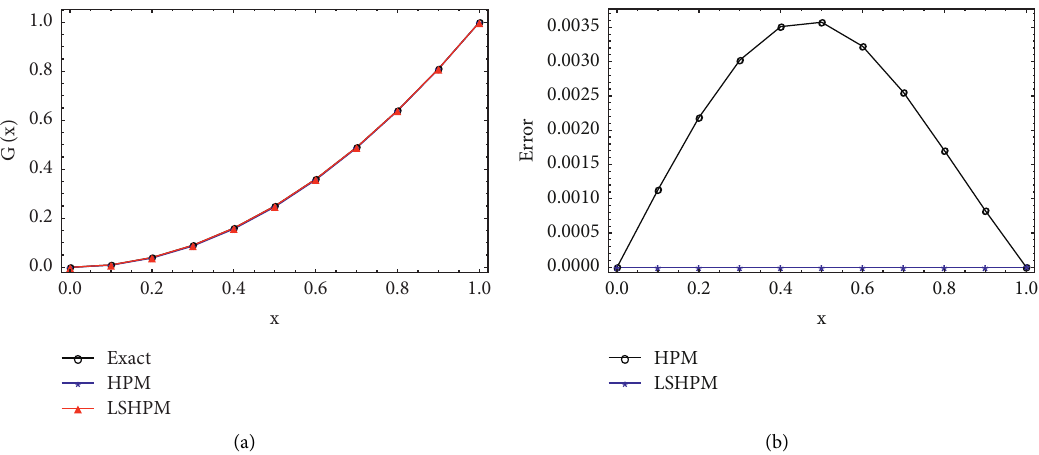
Figure 2: Graphical representation of solutions and errors in Problem 2. (a) Comparison of Exact, HPM, and LSHPM Solutions. (b) Comparison of absolute errors of HPM and LSHPM.